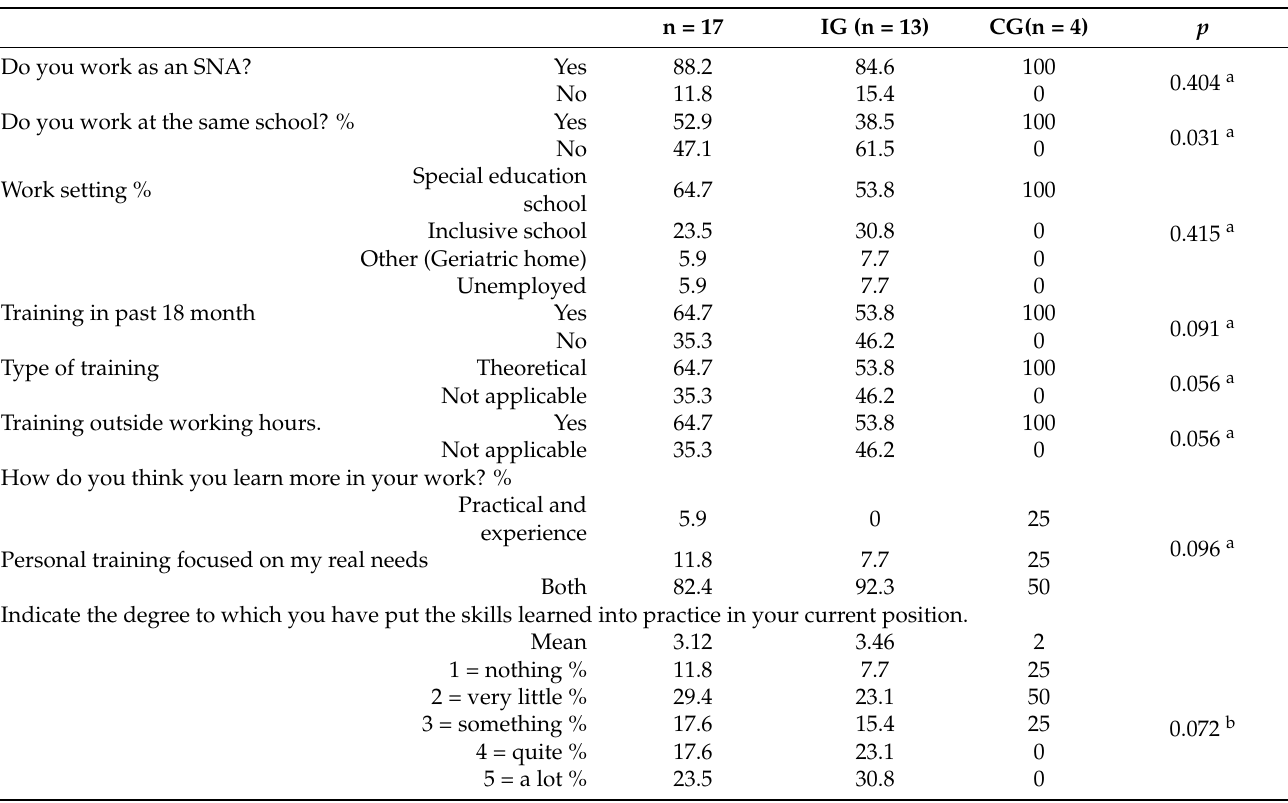
Table 4. Results of Control Call Special Need Assistants